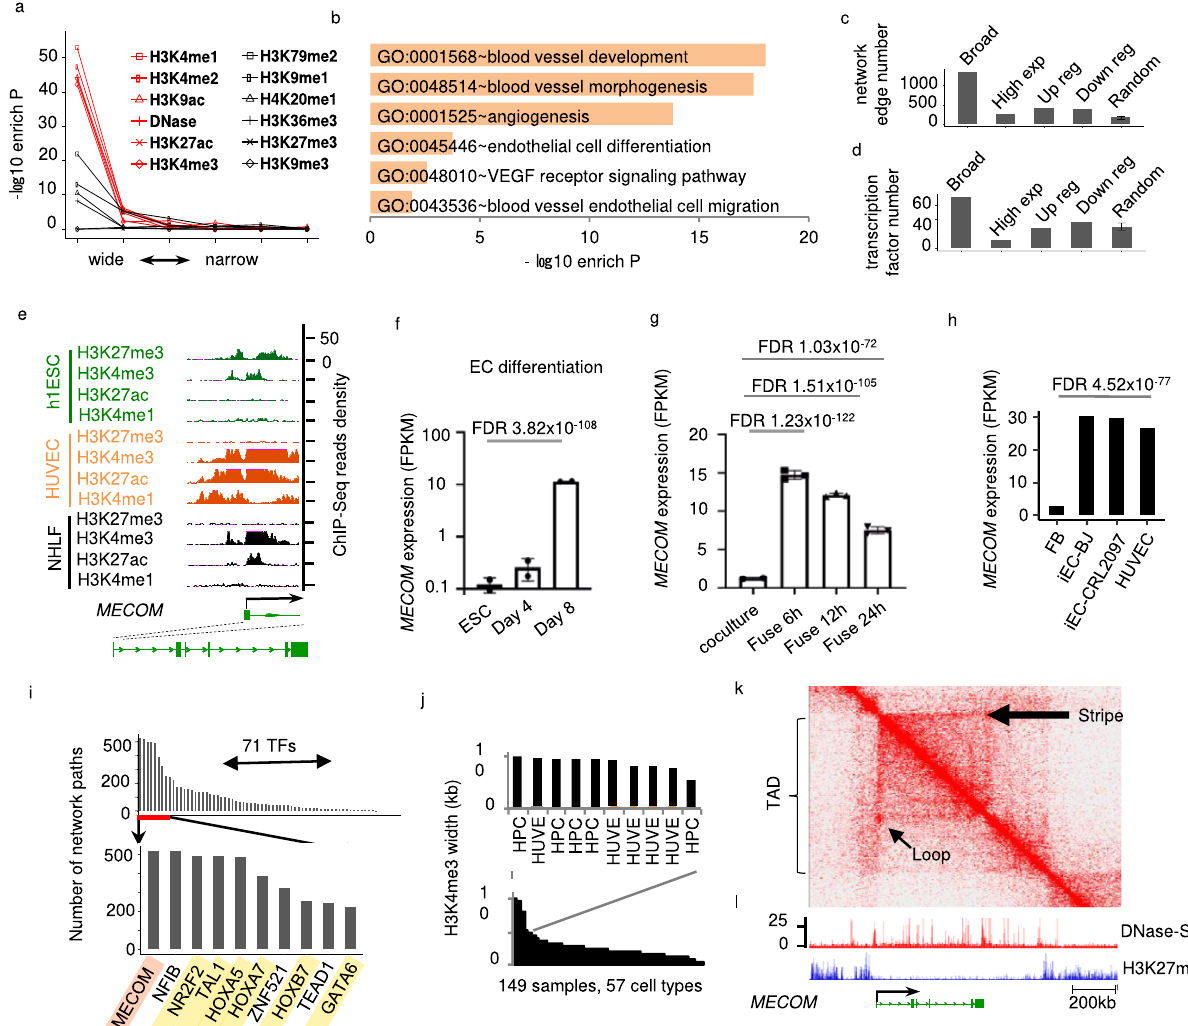
Fig. 1 | Epigenetic landscapes suggest MECOM as a lineage regulator for Endothelial cell (EC). a Enrichment of EC identity regulators plotted against the width of enrichment peak for each chromatin mark. b Pathways enriched in EC putative identity regulators de fi ned by broad enrichment of activating histone modi fi cations. c Number of regulation network edges connected to and ( d ) Num- beroftranscriptionfactorsinECputativeidentityregulatorsorothergenegroups, of which each has the same number of genes. e Signal density of individual chro- matin marks at the MECOM locus in h1ESC, HUVEC and NHLF. f – h Expression level of MECOM atindividual intervalsduring ECdifferentiation mESC ( f ),the formation of mESC-hECheterokayon( g ),and human fi broblast to ECtransdifferentiation( h ). i Numberofgeneregulationnetworkpathsconnectedbyeachtranscriptionfactor (TFs). MECOM is highlighted in red and known EC regulators are highlighted in yellow. Gene regulation network for EC was de fi ned by algorithm and database of